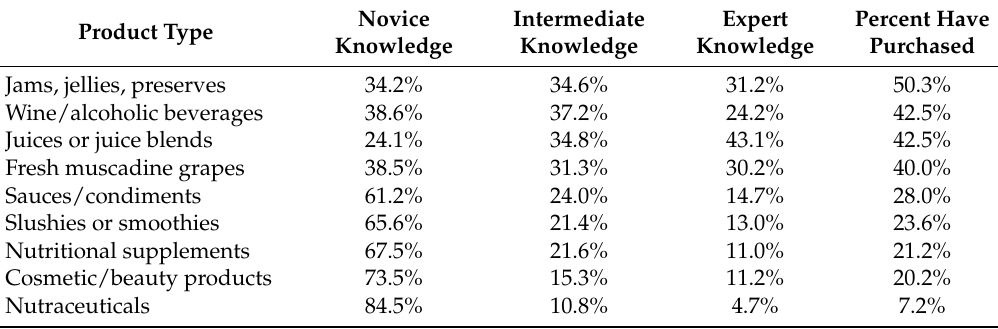
Table 3. Knowledge and purchase of products made with muscadine grapes *.